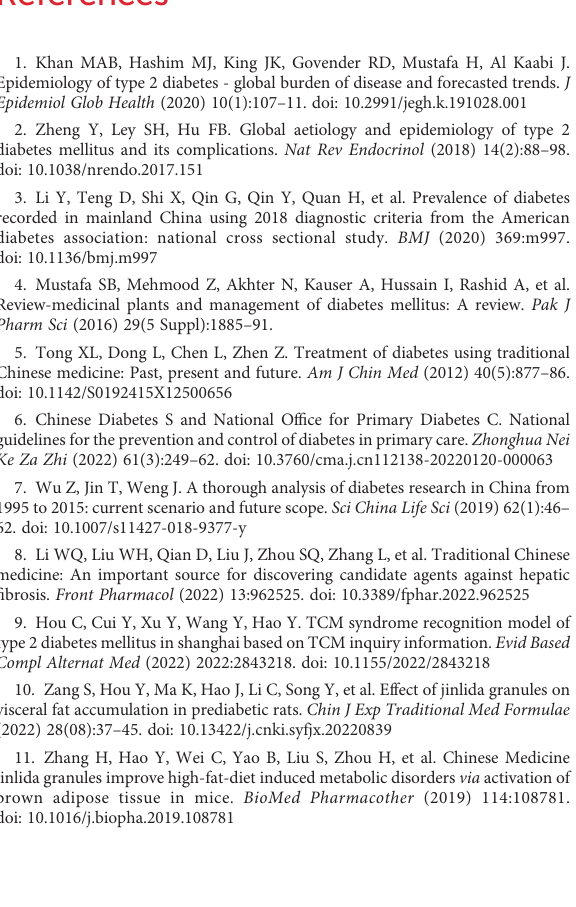
(Jinlida vs. Control). SUPPLEMENTARY FIGURE 2 Weighted Mean Difference of 2h-PG in each RCTs with High Risk of Bias (Jinlida vs. Control). SUPPLEMENTARY FIGURE 3 Weighted Mean Difference of FPG in each RCTs with High Risk of Bias (Jinlida vs.